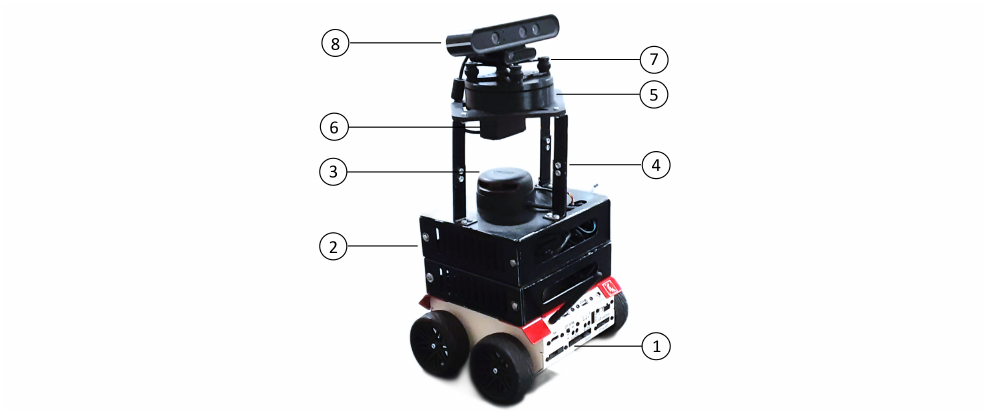
Figure 2. An overview of the mechanical design of ROBOGait. The figure shows: (1) the mobile robotic base, (2) on-board computer (Intel NUC), (3) Slamtec LIDAR A2 sensor, (4) adjustable aluminum brackets, (5) servoing system mechanism, (6) servomotor (Hitec HS-755HB), (7) damping device, and (8) Orbbec Astra RGBD